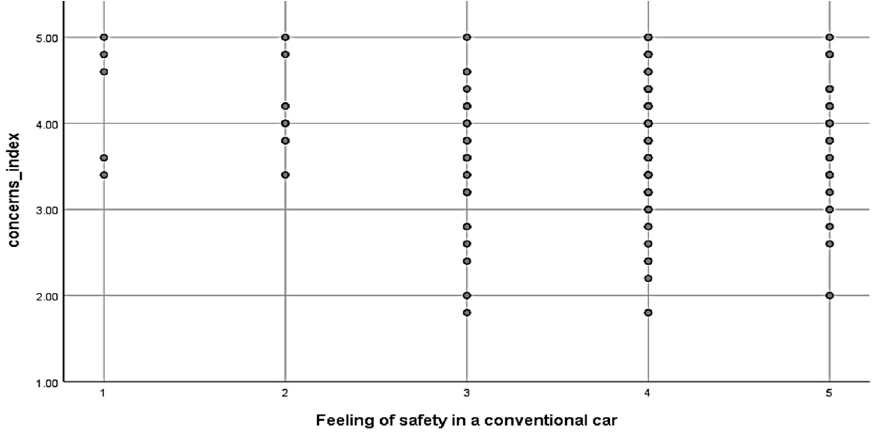
Figure 4. Scatterplot from the variables ‘safety conventional’ and concerns